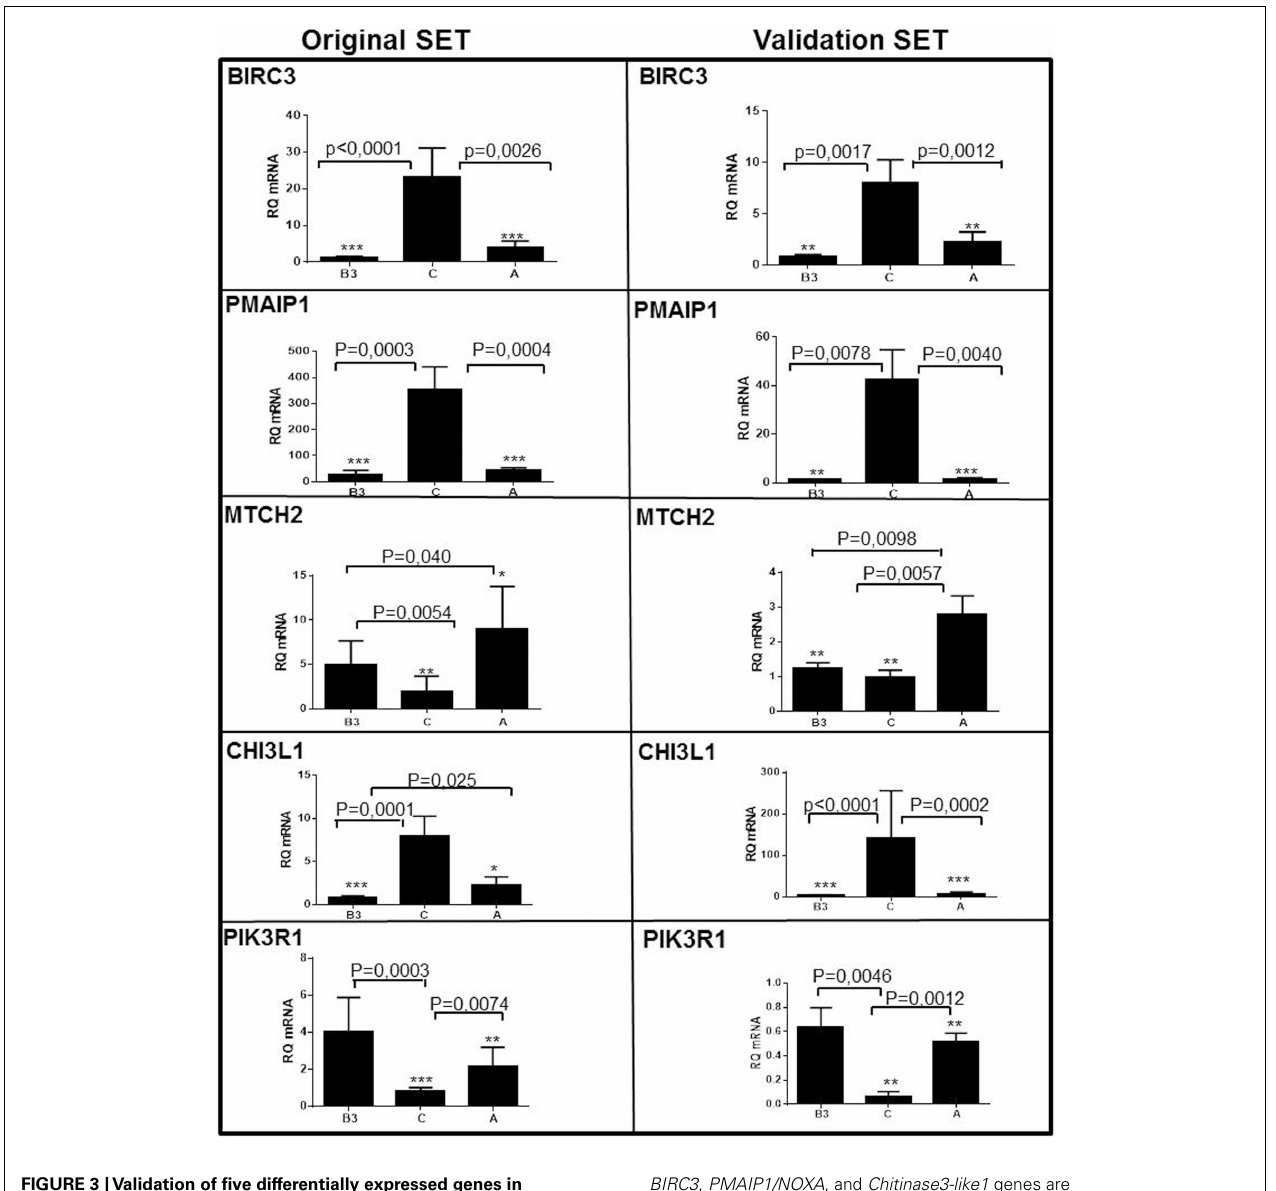
FIGURE 3 |Validation of five differentially expressed genes in typeA and type B3 thymomas and thymic squamous cell carcinomas (TSCC, C) in the original set of tumors (left column; seeTable 1) and the validation set (right column; seeTable 2) .